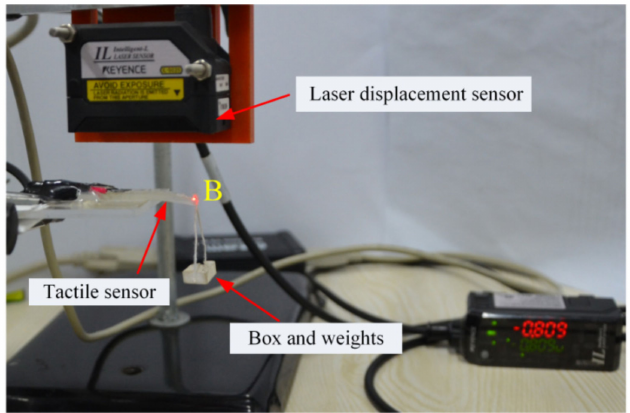
Figure 14. Experimental setup for the equivalent stiffness of the tactile